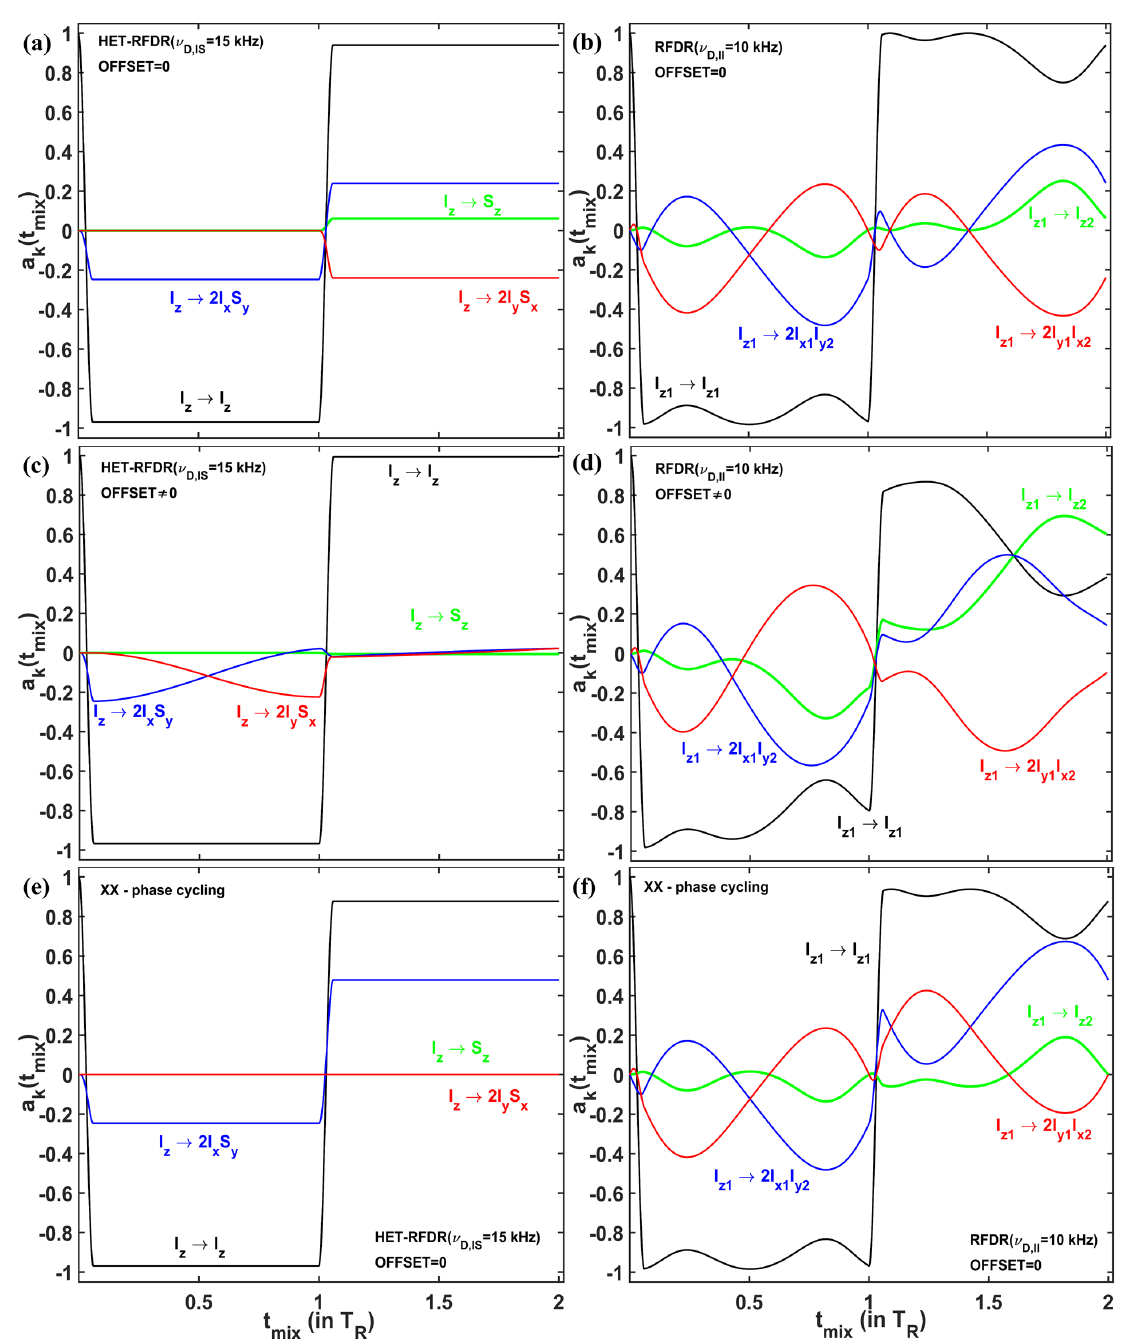
Figure 5. The operator evolution through HET-RFDR and RFDR over two rotor periods. The simulated amplitudes of the operators of a single crystal (Euler angles: 184; 141; 349 ◦ ) for HET-RFDR (a, c) and RFDR (b, d) . For the heteronuclear IS spin system, ν D,IS = 15kHz, and the initial operator is I z , and for the homonuclear I 2 spin system, ν D, II = 10kHz, and the initial operator is I z 1 . The MAS frequency was 10kHz, and the rf field was 83kHz. Black lines – I z and I z 1 ; green lines – S z and I z 2 ; blue lines – 2 I x S y and 2 I x 1 I y 2 ; red lines – 2 I y S x and 2 I y 1 I x 2 . For (a–d) , the phases of the first and second π pulses are X and Y, respectively. Panels (e, f) show the case of IS and I 2 spin systems, respectively, when the phases of the first and second π pulses are both X. (a, b, e, f) Offset values in kHz: 0, 0. (c, d) Offset values in kHz: 2, −